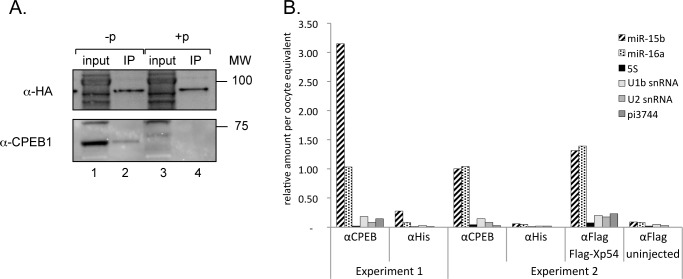
CPEB complexes and miRISC cooperate in the regulation of translational activation of cyclin E1 during oocyte maturation.A. Components of the RISC complex can associate with the translational silencing complex in immature oocytes (-p). Oocytes were injected with HA-Ago2 mRNA, and the resulting lysates were subjected to immunoprecipitation with anti-HA antibodies. Input represents 5% of the immunoprecipitated fractions. Western blotting was performed with anti-HA or -CPEB1 antibodies and visualised by ECL.–p–no progesterone, immature oocytes; +p–oocytes matured with progesterone. B. miRNAs co-immunoprecipitate with CPEB complexes. Lysates from uninjected oocytes or oocytes expressing a FLAG-tagged Xp54 were used for immunoprecipitation using a monoclonal anti-CPEB antibody, an isotype-matched control (His), or in the case of FLAG-Xp54 expressing oocytes and uninjected control (“-“), an anti-FLAG antibody (FLAG). RNA was isolated and real-time RT-PCR performed for the miRNAs and small RNAs indicated. Relative quantities were normalised per oocyte input. For plotting purposes all enrichment values were scaled to the enrichment of miR-15 in the CPEB immunoprecipitate of Experiment 2.